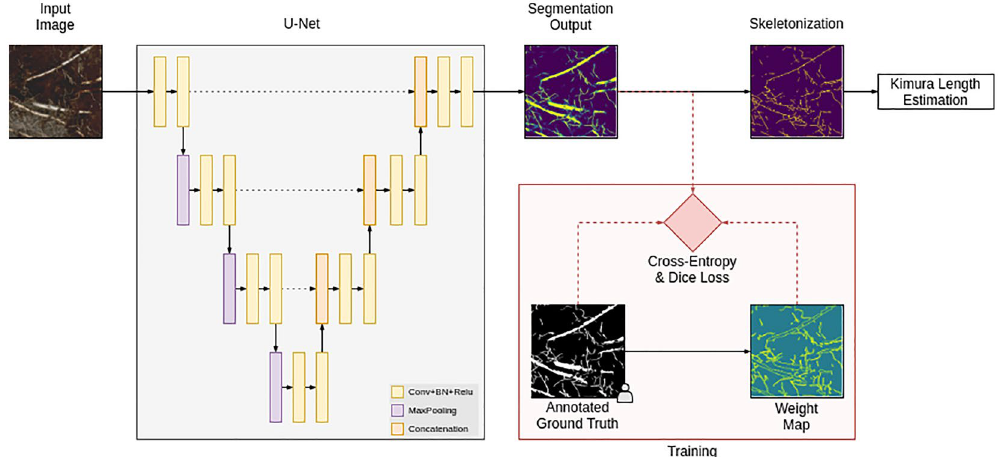
Figure 1. Overview of the RootDetector system. The main component is a semantic segmentation network based on the U-Net architecture. The root length is estimated by skeletonizing the segmentation output and applying the formula introduced by Kimura et al. 17 . During training only, a weight map puts more emphasis on fine